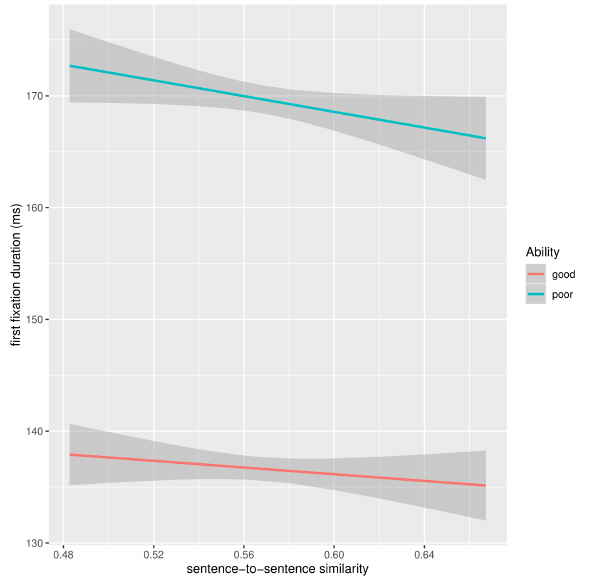
Figure 5. Decomposition of viewing times as a function of grade and reading ability